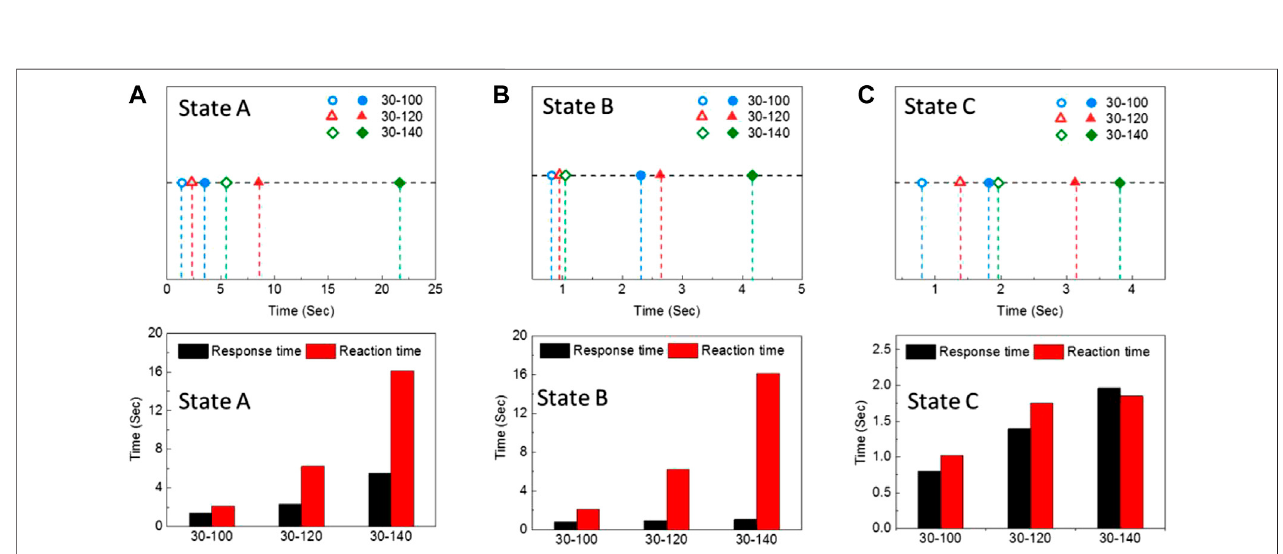
FIGURE 6 | The self-deployment response and reaction time results of (A) state A, (B) state B and (C) state C with various size. In the top row of graphs, the response time is from zero to the hollow point, and the reaction time is from the hollow point to the solid point.